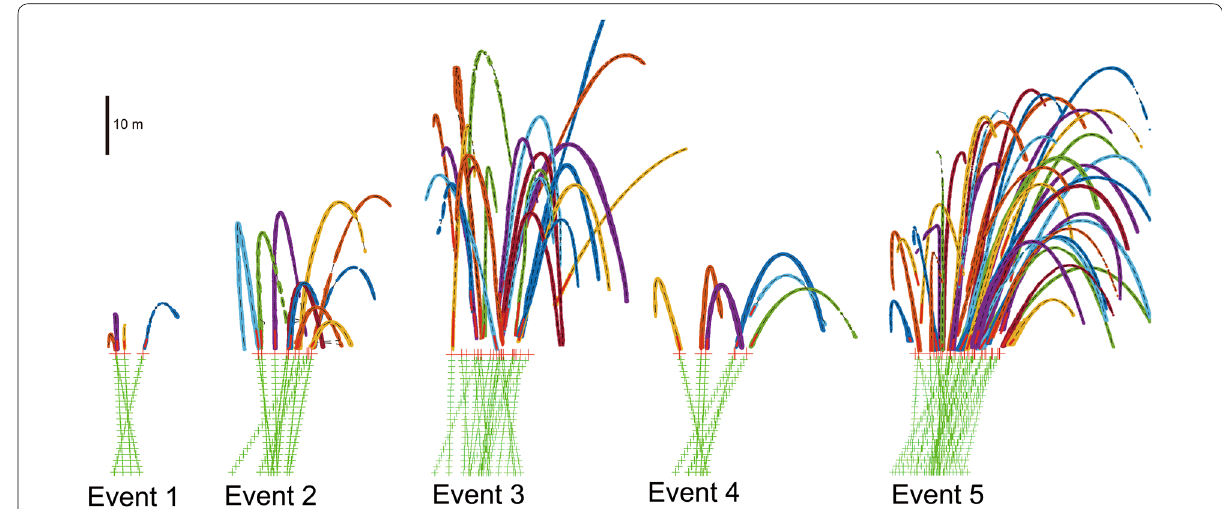
Fig. 8 Trajectories extrapolated back into the conduit to estimate the particle release depth. Straight lines show the convergence at a depth of 11–13 m (Table 6). The convergence width in a horizontal direction is shown in Table 6